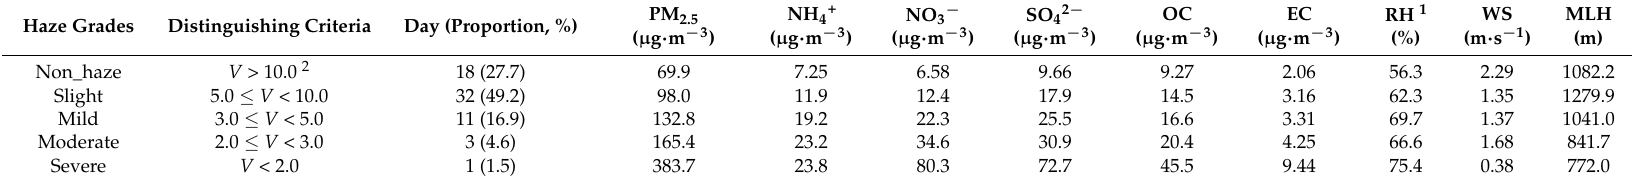
Table 3. Mass concentrations of PM 2.5 and its components, and the meteorological parameters under different haze pollution levels. Haze